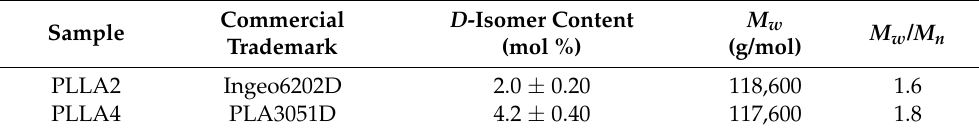
Table 1. Names of samples analyzed; molar % in D -lactic acid units; molecular mass and polydisper- sity results of the used PLLA grades estimated after their